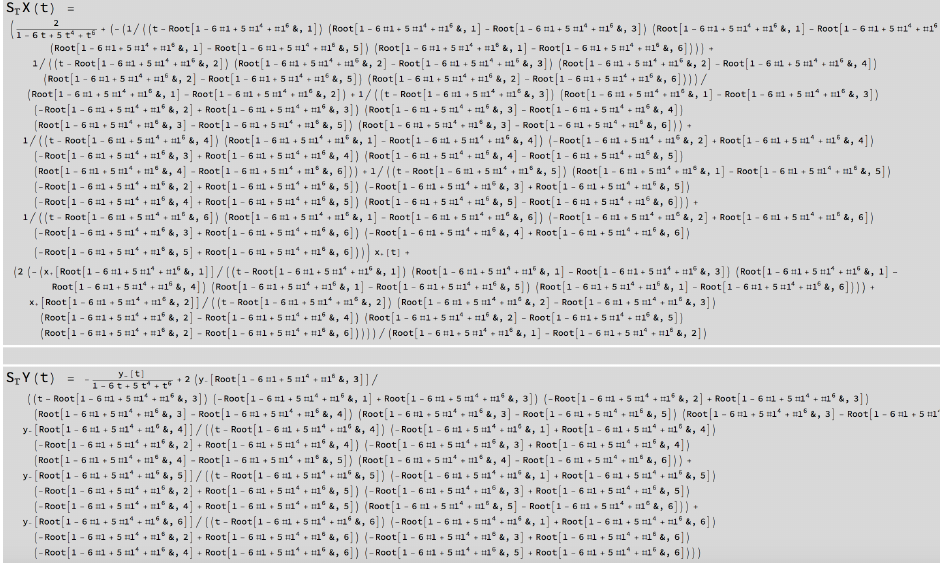
Figure 65. Output given by the [SInt] 2.0 algorithm.